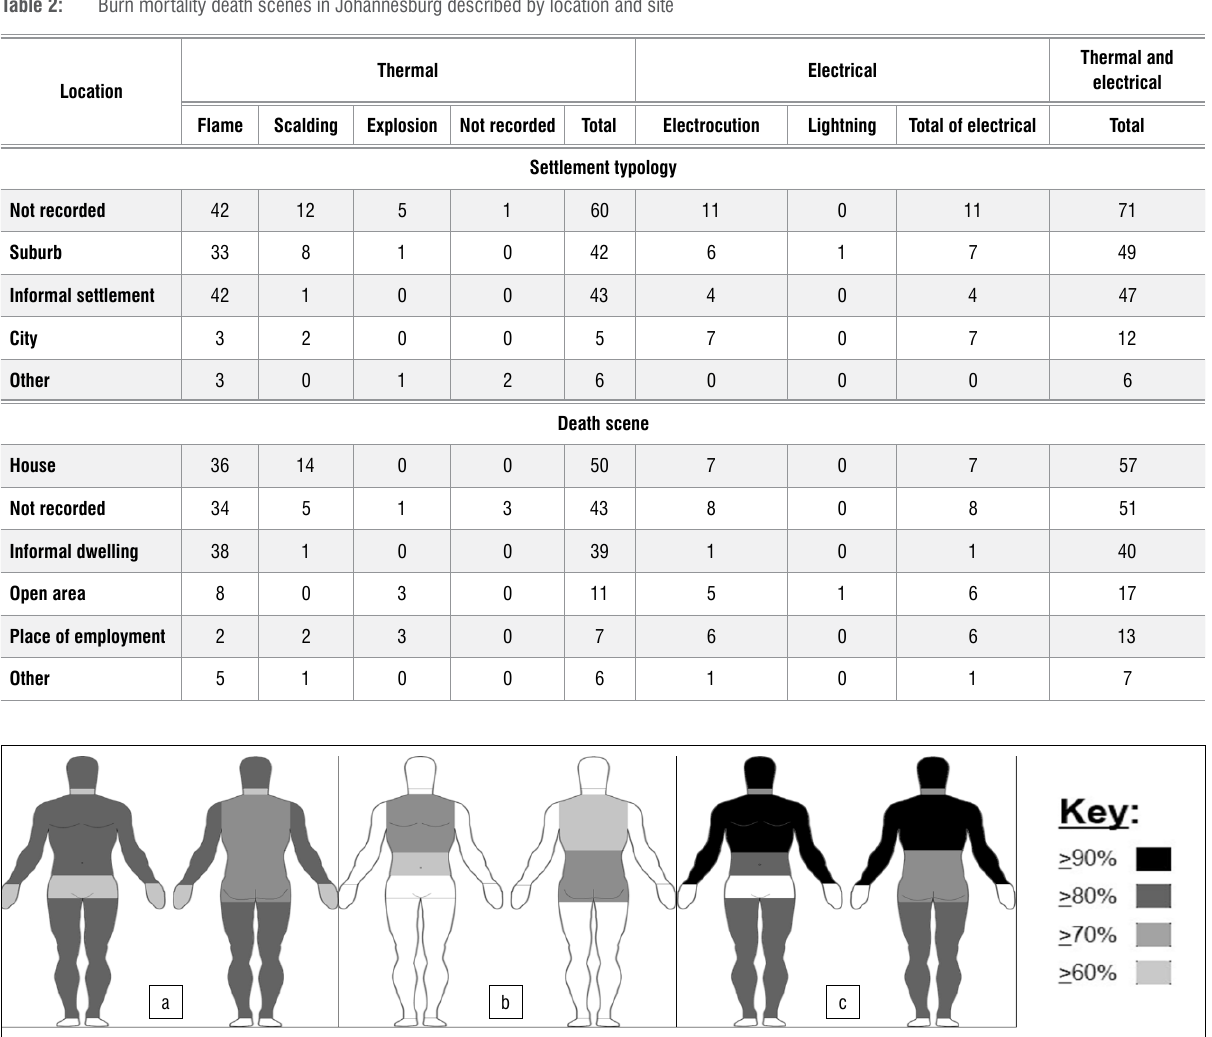
Figure 3: Body regions that exhibited thermal burn injuries in >60% of fatal burn cases caused by (a) flames, (b) scalding, and (c) explosion; on the anterior (left) and posterior (right) body